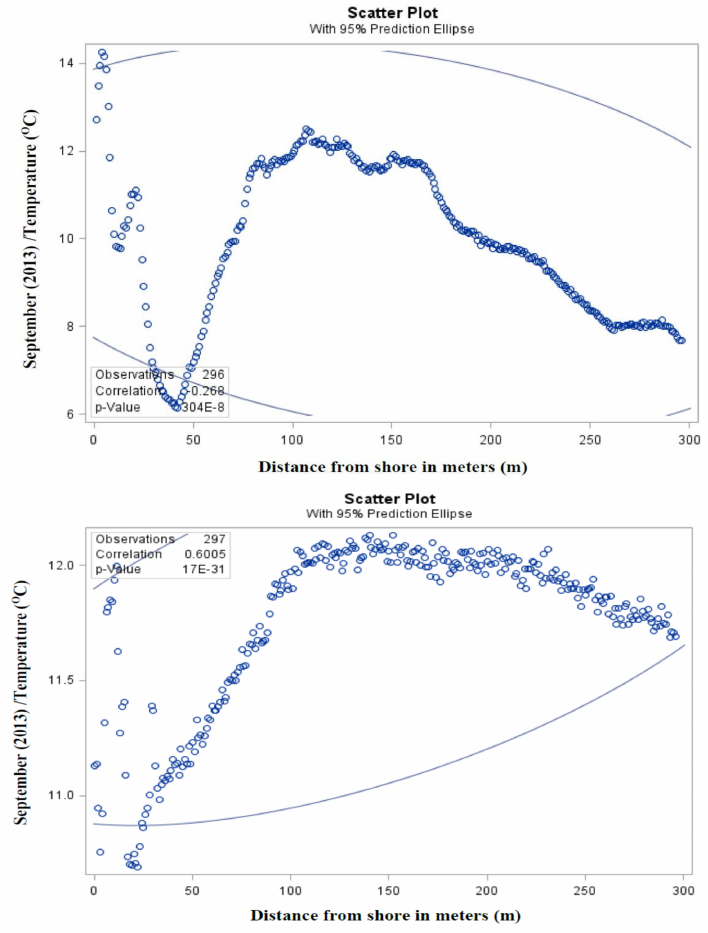
Figure 6. Plot showing Pearson’s correlations between September 2013 temperature and distance at Suvilahti, in the city of Vaasa. Ketunkatu (above) and Liito-oravankatu (below). The meaning of p -value = 304E − 8 = 304 × 10 − 8 (above). The meaning of p -value = 17E − 31 = 17 × 10 − 31